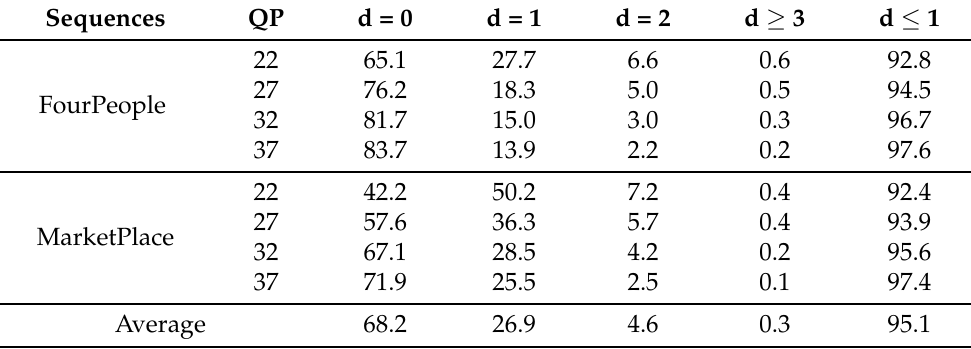
Table 4. The distribution of the QT depth difference between adjacent frames (unit: %).